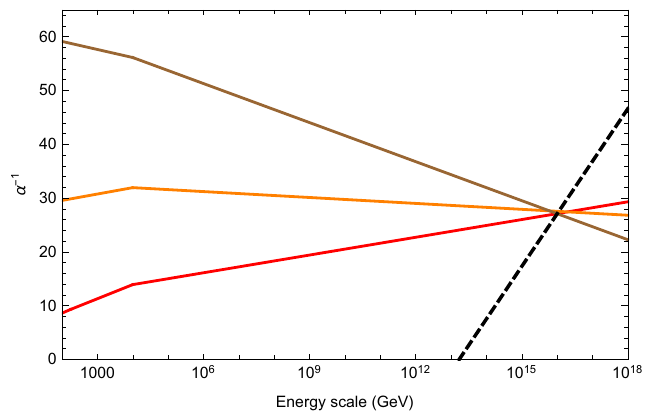
Figure 2 . Running of gauge couplings in a supersymmetric scenario. HC gauge coupling corre- sponds to the dashed black line. See